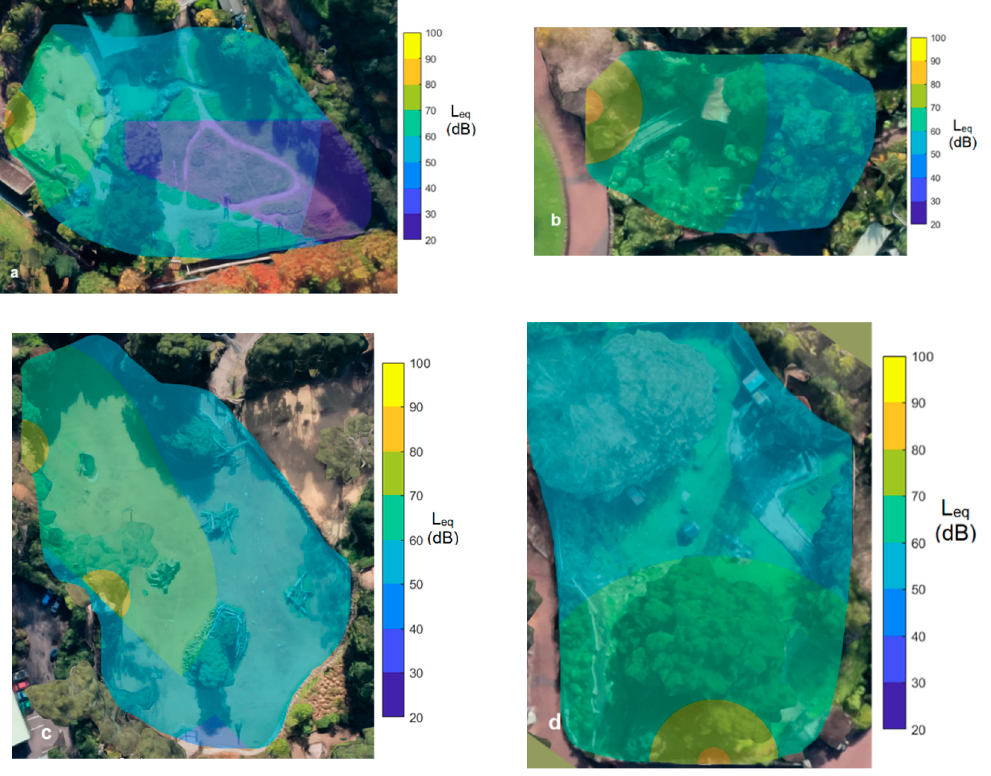
Figure 2. Contours of predicted L eq (dB) at focal species ear heights in the ( a ) elephant, ( b ) alligator, ( c ) giraffe and ( d ) emu enclosure. (Imagery ©2019 Google, MapData Sciences Pty Ltd., PSMA).